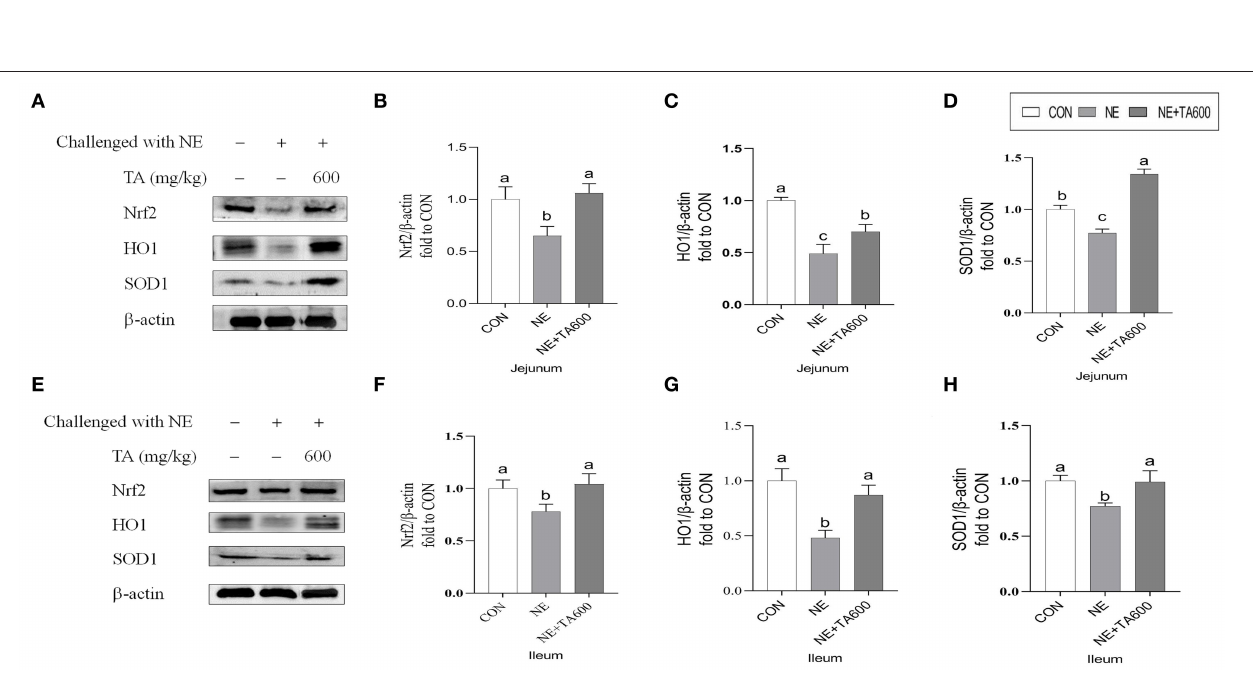
FIGURE 4 | Effects of TA on the relative protein abundance of Nrf2 and SOD1 in the jejunum and ileum of subclinical NE broilers. (A–D) The protein abundance of Nrf2, HO1, and SOD1 in the jejunum; (E–H) The protein abundance of Nrf2, HO1, and SOD1 in the ileum. Values are means with their standard errors represented by vertical bars. a − c Means within a row with different letters differ significantly ( p < 0.05). Nrf2, nuclear factor erythroid 2-related factor 2; HO1, hemeoxygenase 1; SOD1, superoxide dismutase